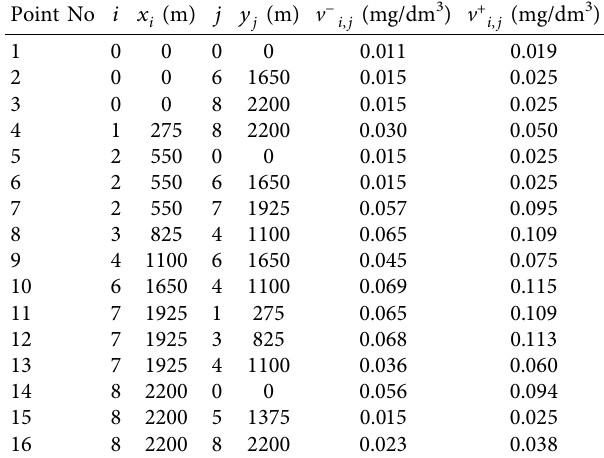
Table 3: The results of predicting the nitrogen dioxide concen- trations at control